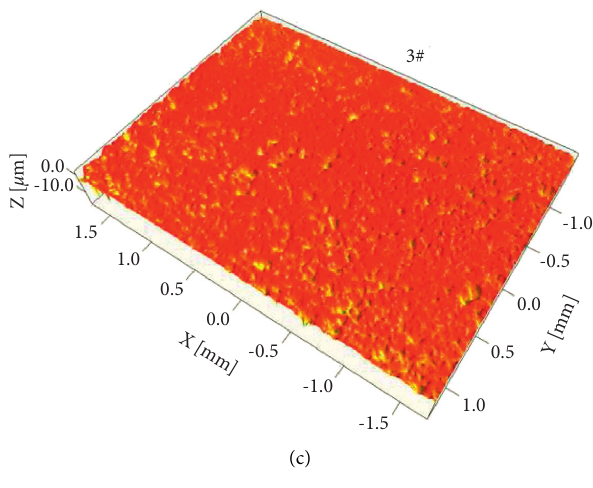
Figure 2: SEM micrographs of shale surfaces. Table 1: Values of the surface morphology parameters of the shale